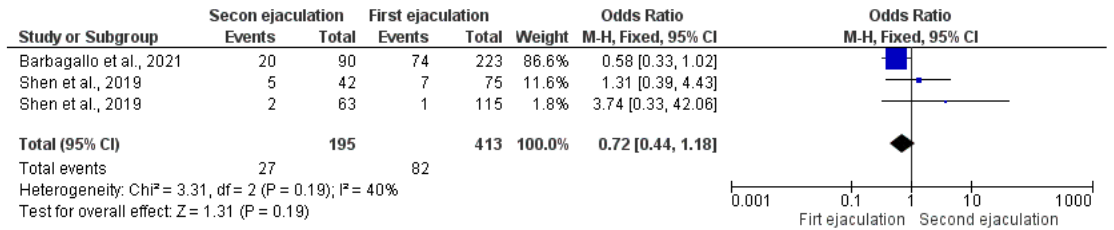
Figure 5. Forest plot showing the effects of a very short abstinence period on the live birth rate.